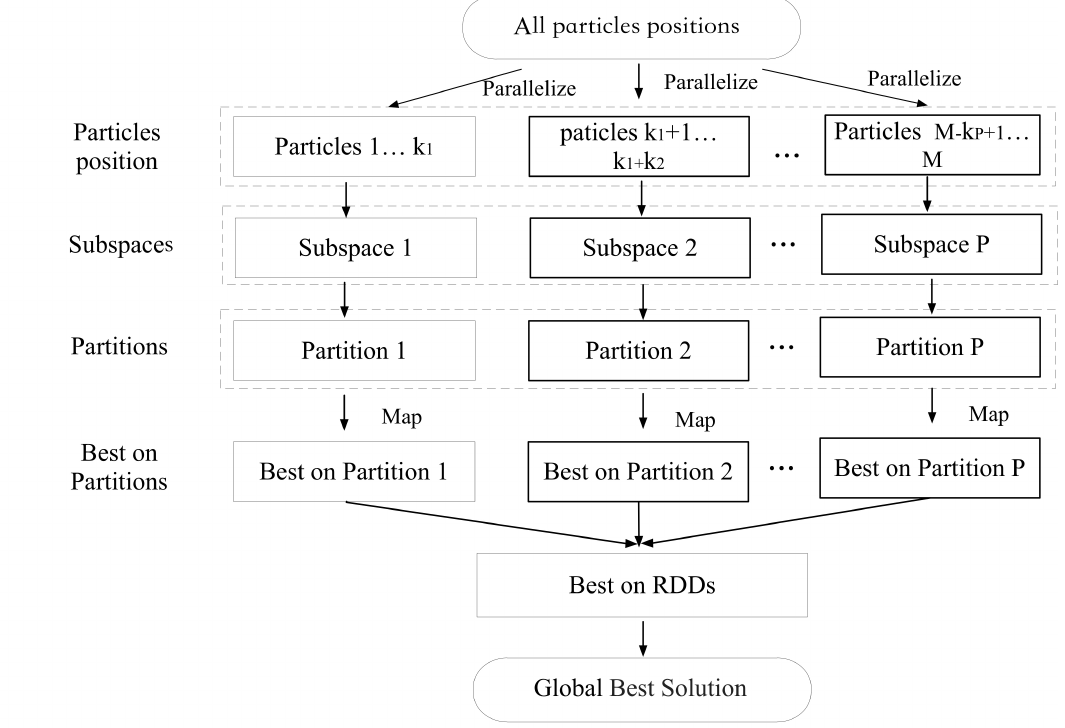
Figure 3. Data distribution of the proposed SDCEA